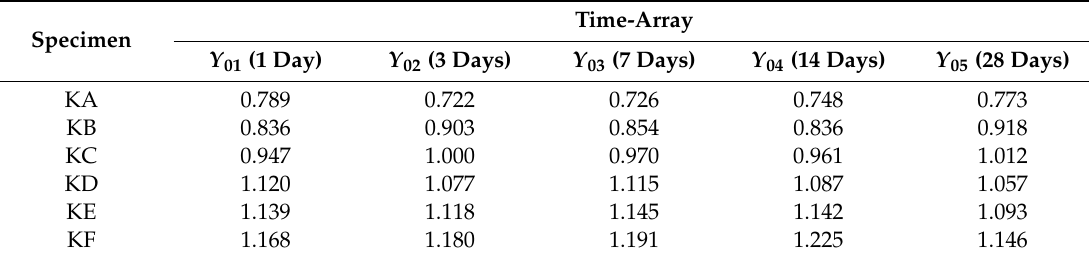
Table 5. Time ranges of the main-array.